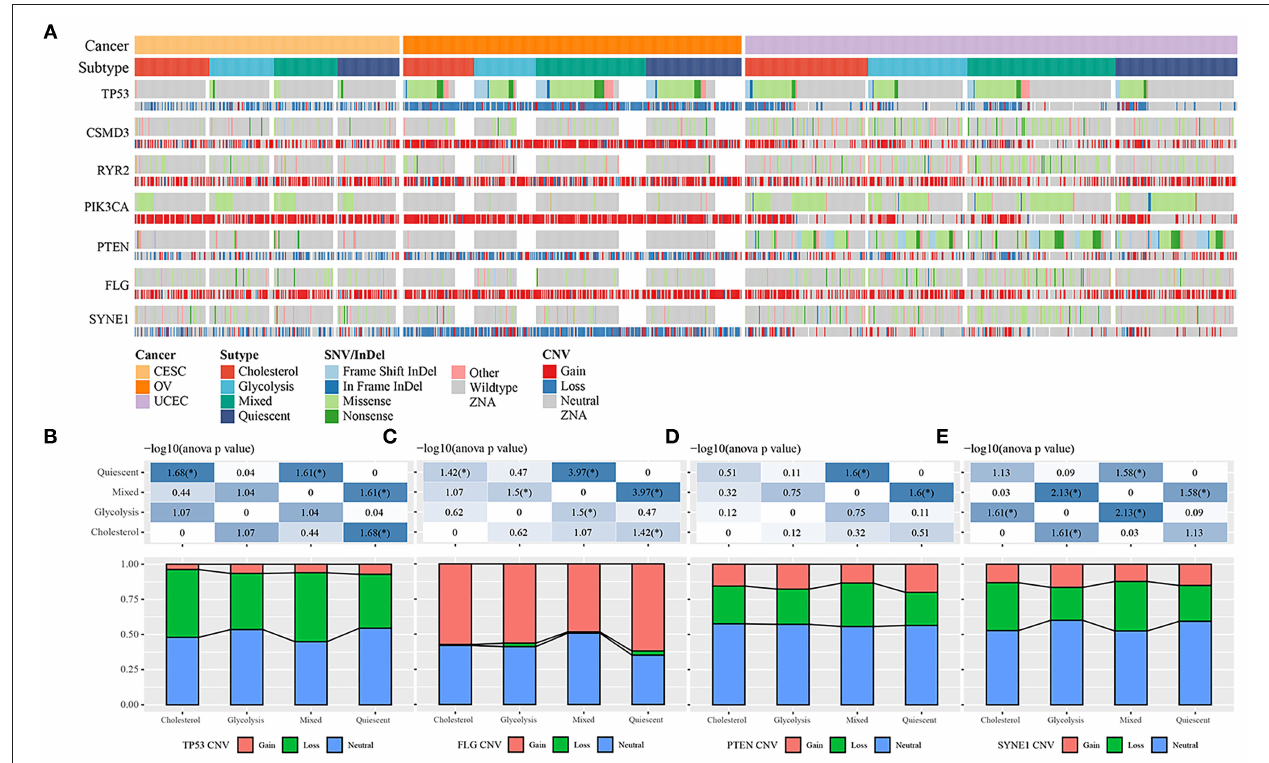
FIGURE 2 | (A) Comparison of the distribution of TP53, FLG, PTEN, and SYNE1 in different cancer subtypes. (B) The distribution of copy number status of TP53 gene in different subtypes. (C) The distribution of the copy number status of the FLG gene in different subtypes. (D) Distribution of copy number status of PTEN gene in different subtypes. (E) The distribution of copy number status of SYNE1 gene in different subtypes.